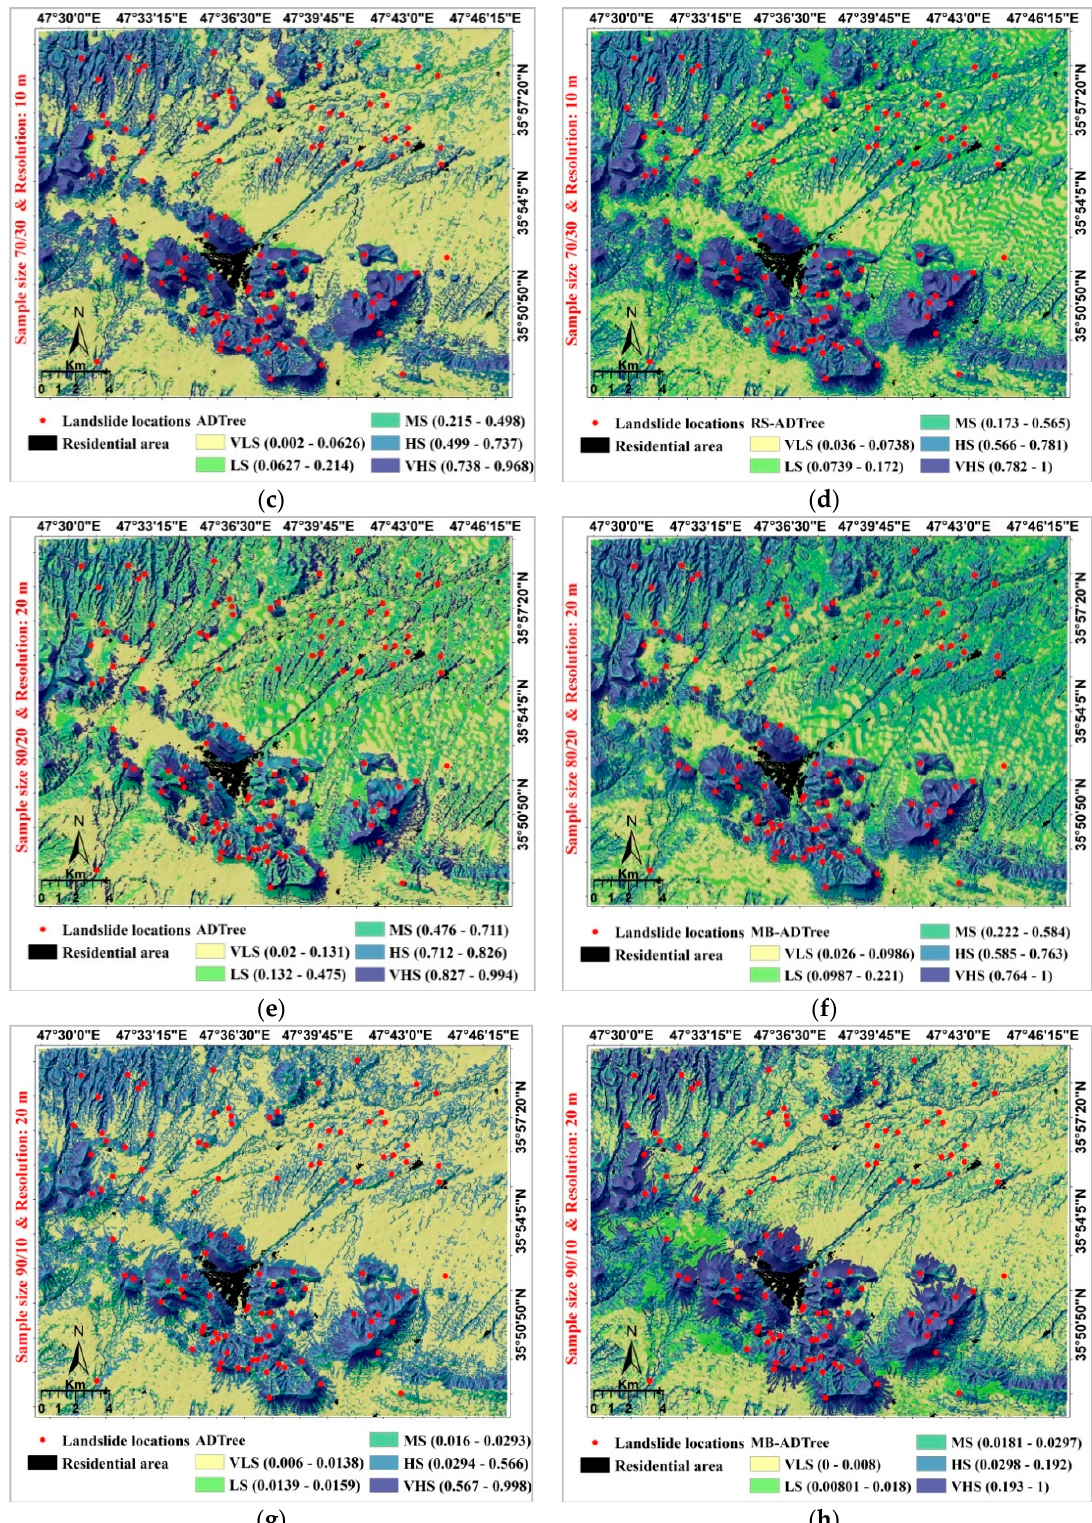
Figure 6. Landslide susceptibility mapping prepared by the ADTree model and its ensemble: ( a )